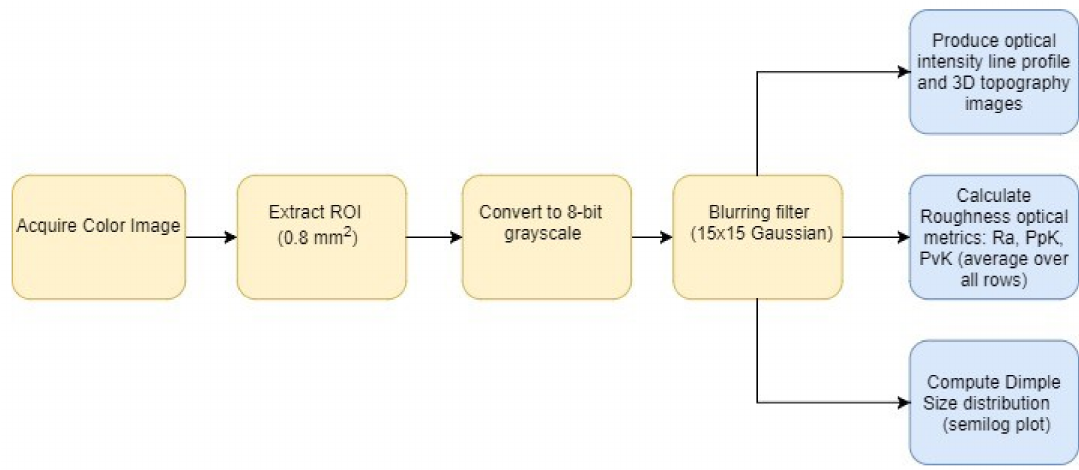
Figure 5. Image processing algorithm for analysis.